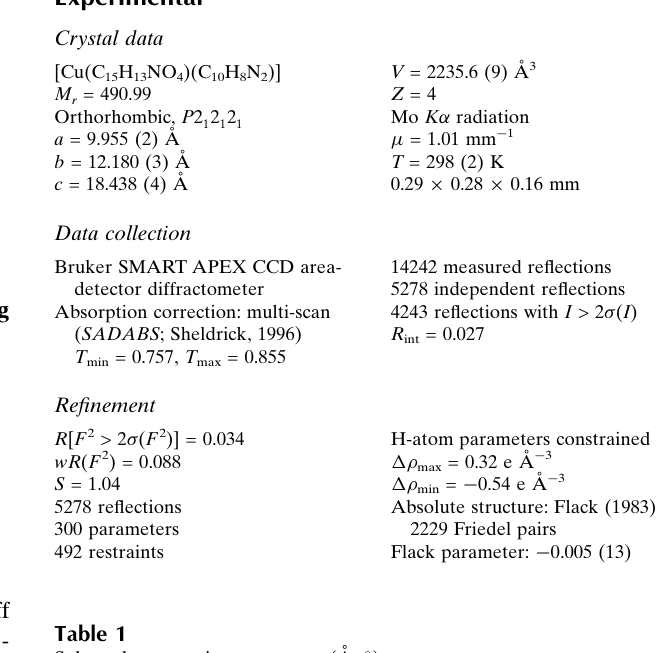
Selected geometric parameters (A˚ , (cid:4) ).